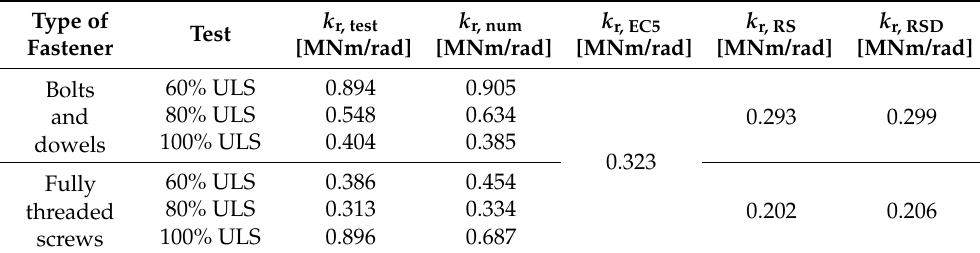
Table 18. Comparison of rotational stiffness